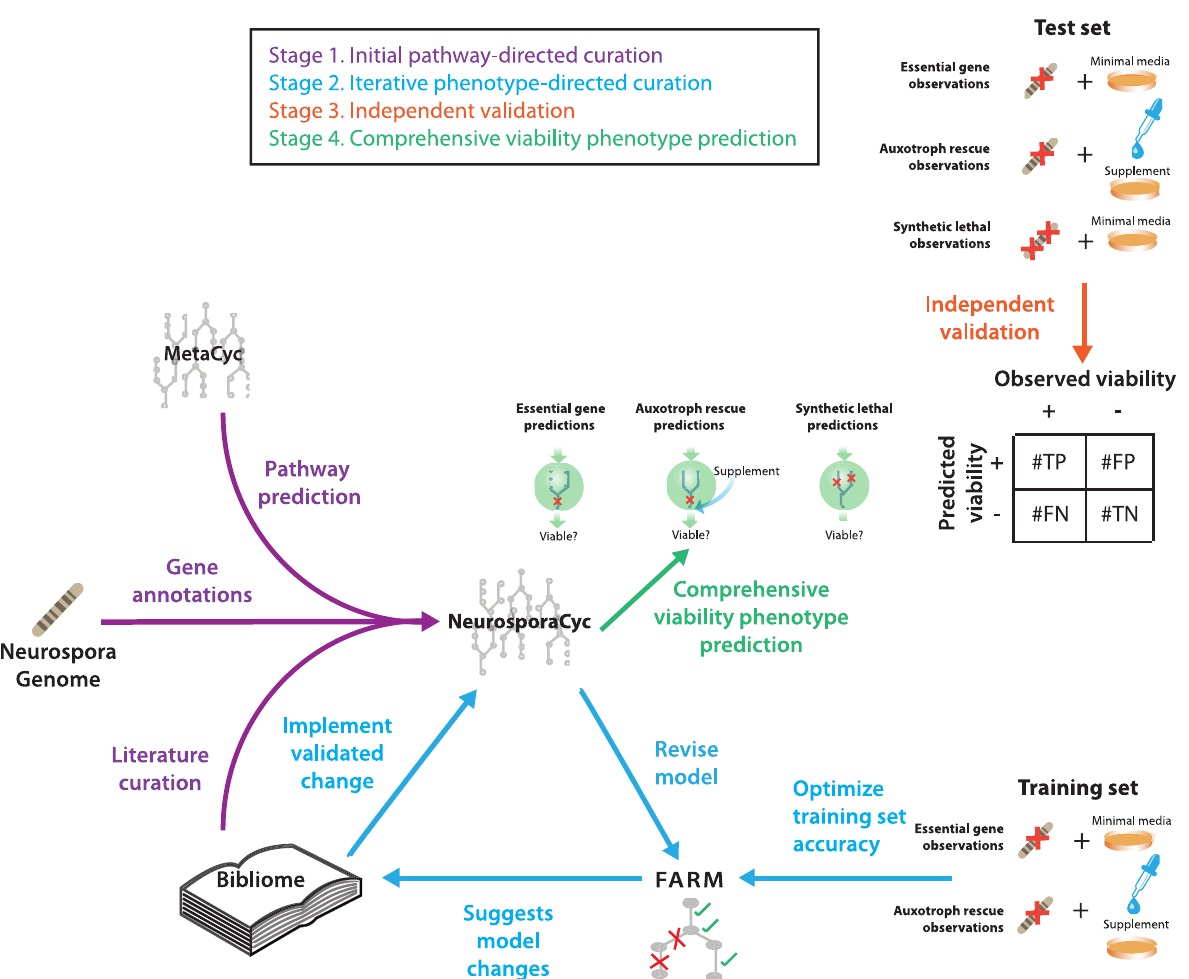
Figure 1. Modeling process. The process used for the reconstruction and validation of the metabolic model is described in four stages. In the first stage, pathway-directed curation , the genome sequence annotation [14,15] , metabolic pathways derived from MetaCyc [34,111] and experimental evidence from the Neurospora bibliome [37] were used to construct the first draft of the NeurosporaCyc Pathway/Genome database [112]. For the second stage, iterative phenotype-directed curation , we utilized FARM to suggest changes to the metabolic network based on a training set of experimentally observed growth phenotypes. These suggestions were reviewed manually, and accepted into the final model only if they were consistent with published experimental evidence. In the third stage, we independently validated the model based on a test set of experimentally observed viability phenotypes that were not utilized during model construction. In the fourth stage, we comprehensively predicted the phenotypes of all essential genes, nutrient rescues, and synthetic lethal